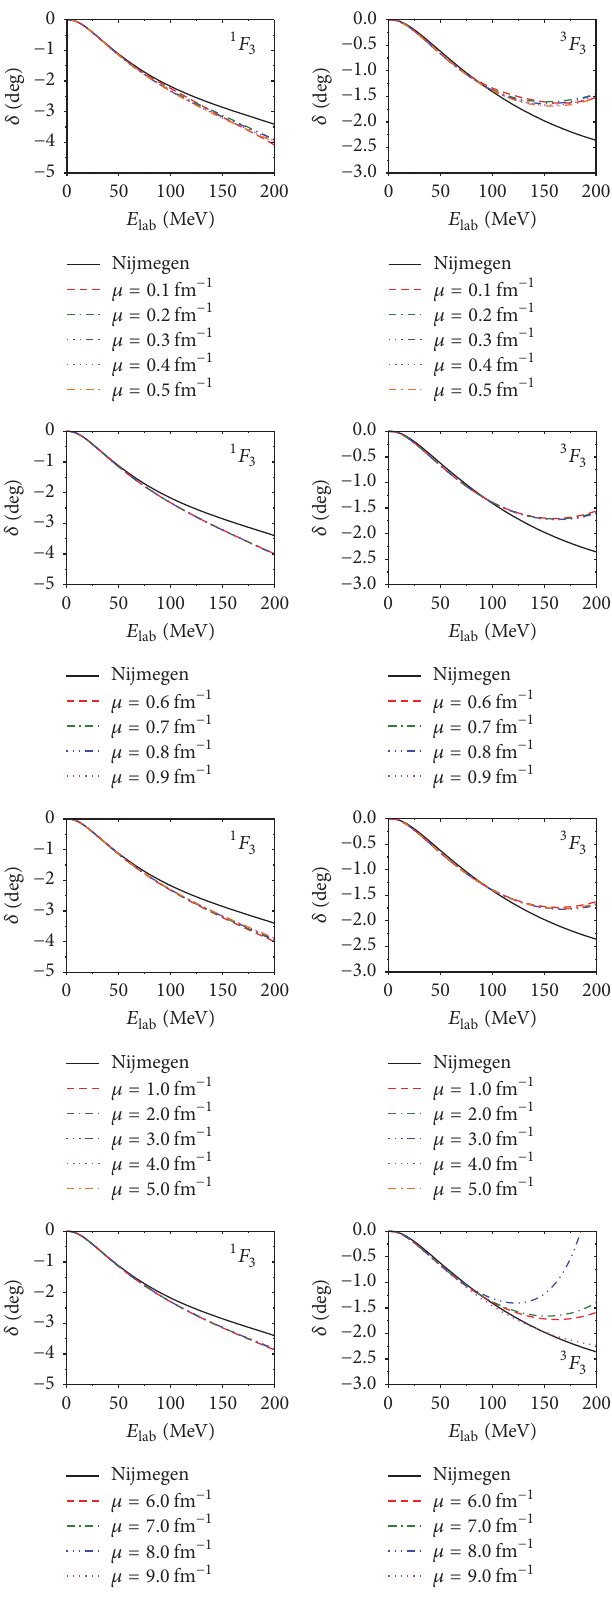
Figure 1: (Color on-line) phase shifts in 1 𝐹 3 and 3 𝐹 3 uncoupled channels calculated from the solution of the subtracted LS equation for the 𝐾 -matrix with five subtractions for the N3LO-EM potential for several values of the renormalization scale compared to the Nijmegen partial wave